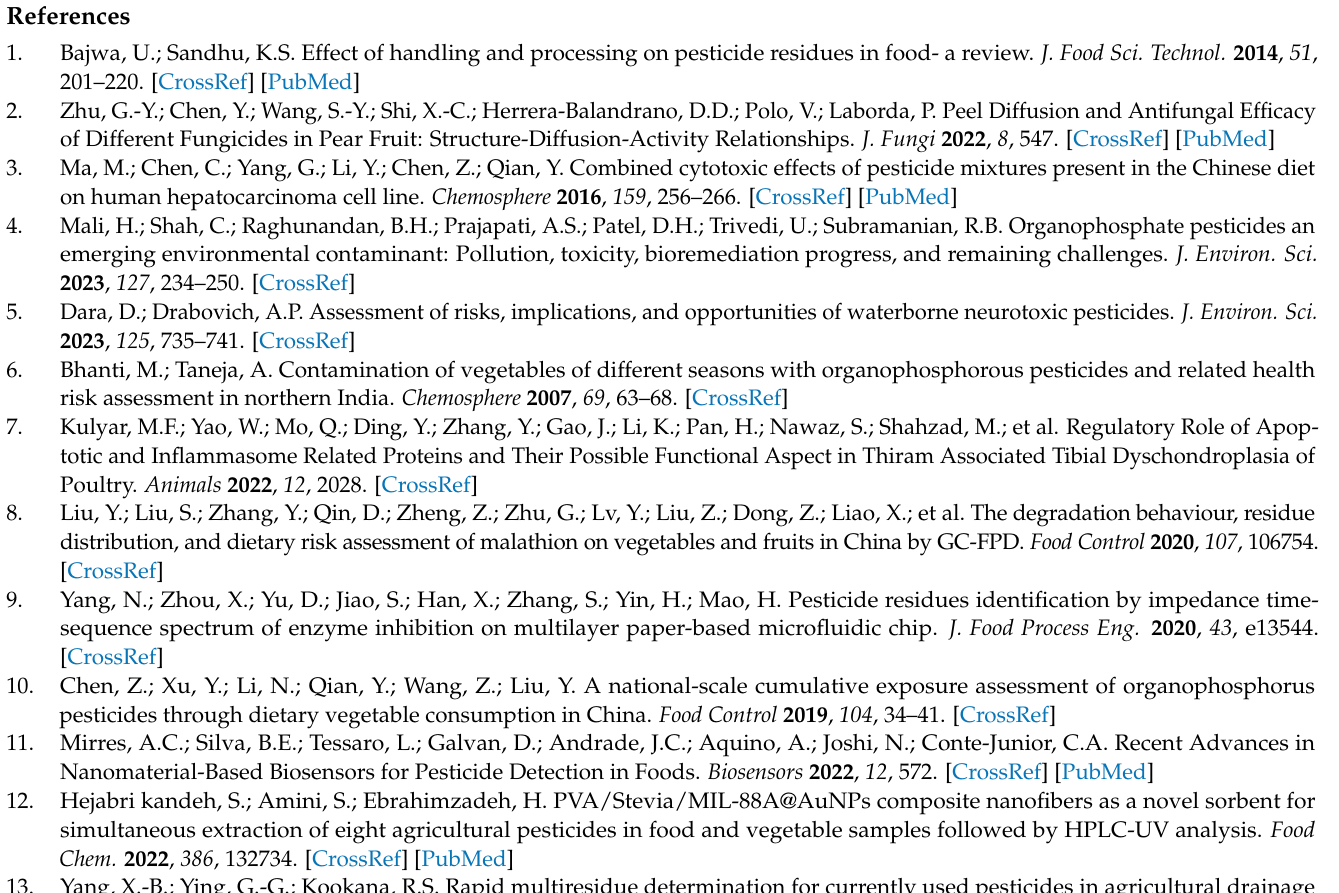
Figure S3: SERS spectrum of 100 µ g L − 1 R6G on AgNPs-PDMS substrate (red curve); and Raman spectrum of R6G powder acquired under the same condition (black curve). Figure S4: Normalized SERS (red curve) and Raman (black curve) spectra of three tested pesticides: thiram (a), malathion (b), and phoxim (c)